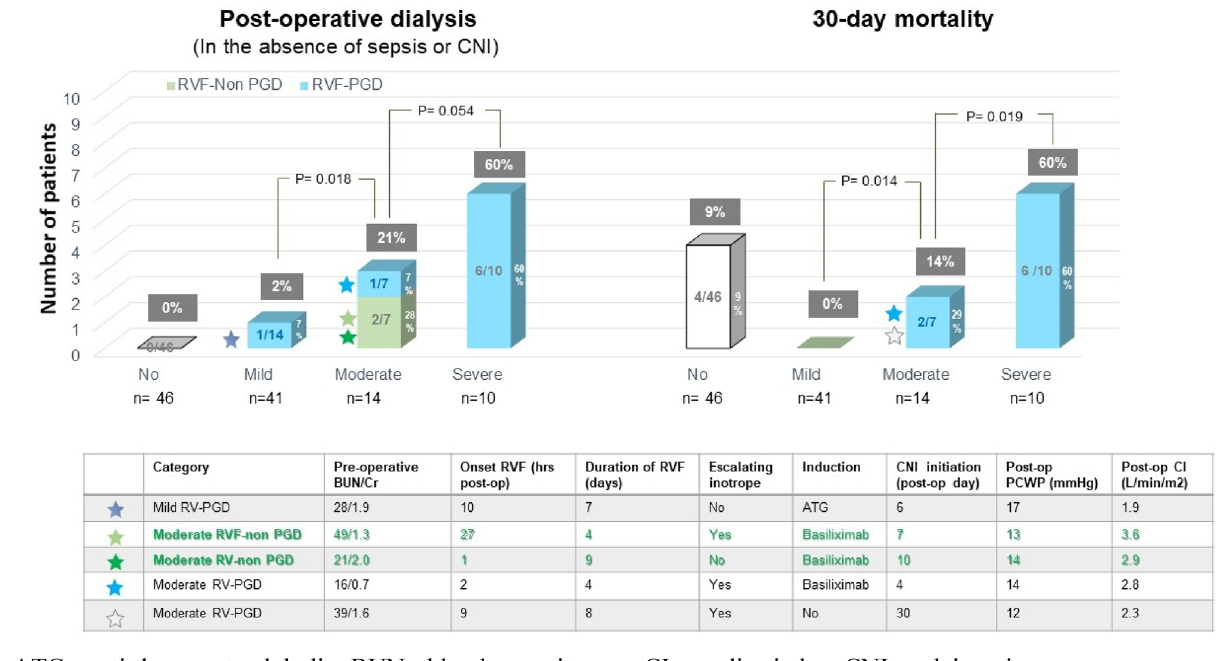
Figure 3. Post-operative requirement of dialysis and 30-day mortality in patients with mild and moderate right ventricular (RV) failure stratified by primary graft dysfunction (PGD) and non PGD and severe RV failure/